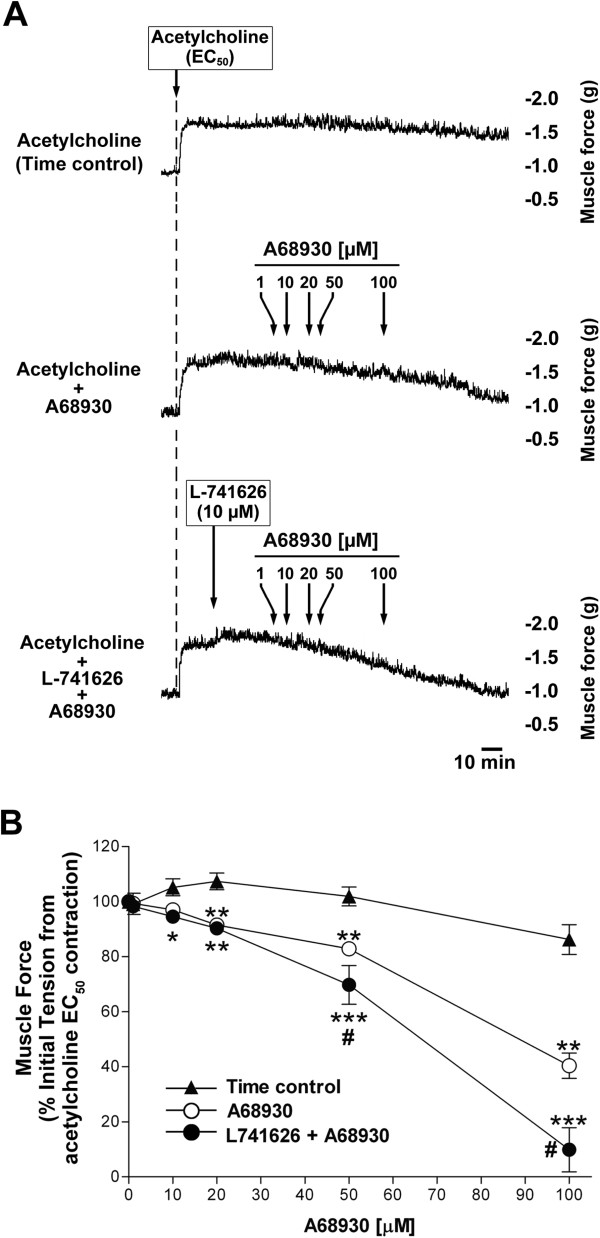
Selective dopamine D1 receptor agonist induced airway smooth muscle relaxation after an acetylcholine EC50 contraction in intact guinea pig trachea. The dopamine D1-like receptor agonist, A68930, in a concentration-dependent manner, relaxes Ach-induced contractions in guinea pig tracheal rings. (A) Representative tension tracing in guinea pig tracheal ring illustrating relaxation of Ach (EC50) contraction by A68930 (1 - 100 μM) in the presence or absence of dopamine D2 receptor selective antagonist L-741626 (10 μM). (B) The effect of cumulative concentration of A68930 (1 - 100 μM) on Ach (EC50)-induced guinea pig tracheal ring contraction in the presence or absence of L-741626 (10 μM). Open circles: A68930 alone. Filled circles: L-741626 + A68930. Filled triangle: time control. Means ± SEM. *P < 0.05, **P < 0.01 and ***P < 0.001 compared with time control. #P < 0.05 compared with A68930 alone. N = 6.